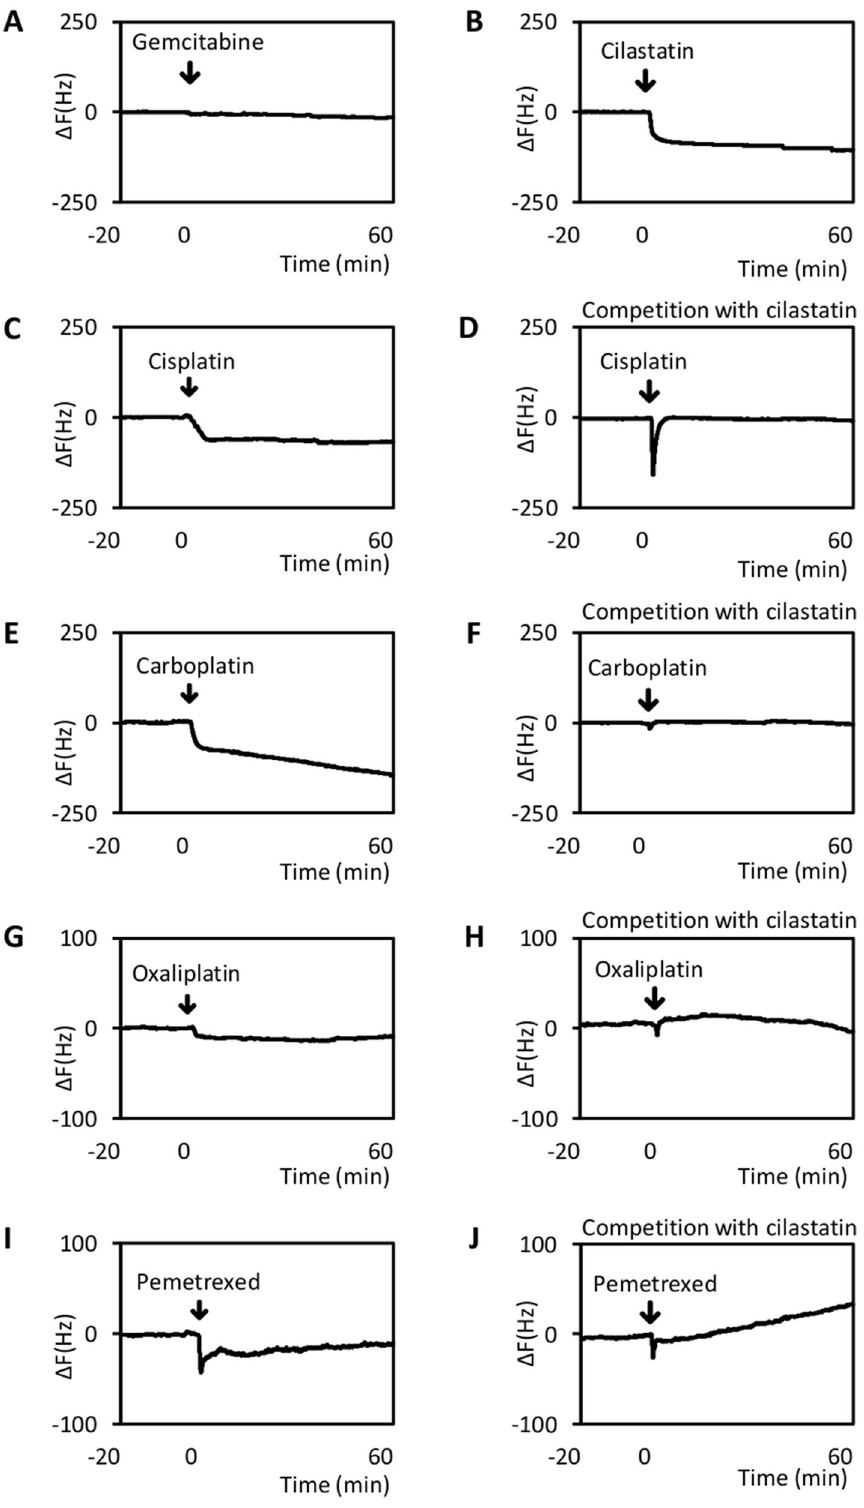
Figure 5. QCM analysis. ( A ) Gemcitabine (20 mg/ml), ( B , D , F , H , J ) cilastatin (10 mg/ml), ( C and D ) cisplatin (1.38 mg/ml), ( E and F ) carboplatin (4.44 mg/ml), ( G and H ) oxaliplatin (7 mg/ml) and ( I and J ) pemetrexed (2.85 mg/ml) in buffer B were administered at the time points indicated by the arrows. Megalin was immobilized on the QCM sensor chip to evaluate the binding of anticancer drugs to megalin. QCM analysis revealed that gemcitabine did not bind megalin ( A ); however, megalin was bound by cilastatin ( B ), cisplatin ( C ), carboplatin ( E ), oxaliplatin ( G ) and pemetrexed ( I ). Cilastatin competed with these drugs for megalin binding ( D , F , H and J